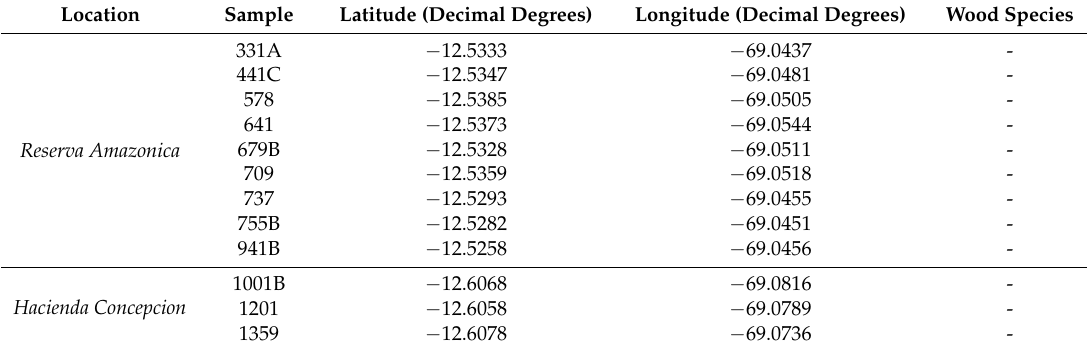
Table 2. GPS coordinates of fallen wood with suspected Chlorociboria spp. taken with GPSmap 64s in Field Station Inkaterra, Madre de Dios,